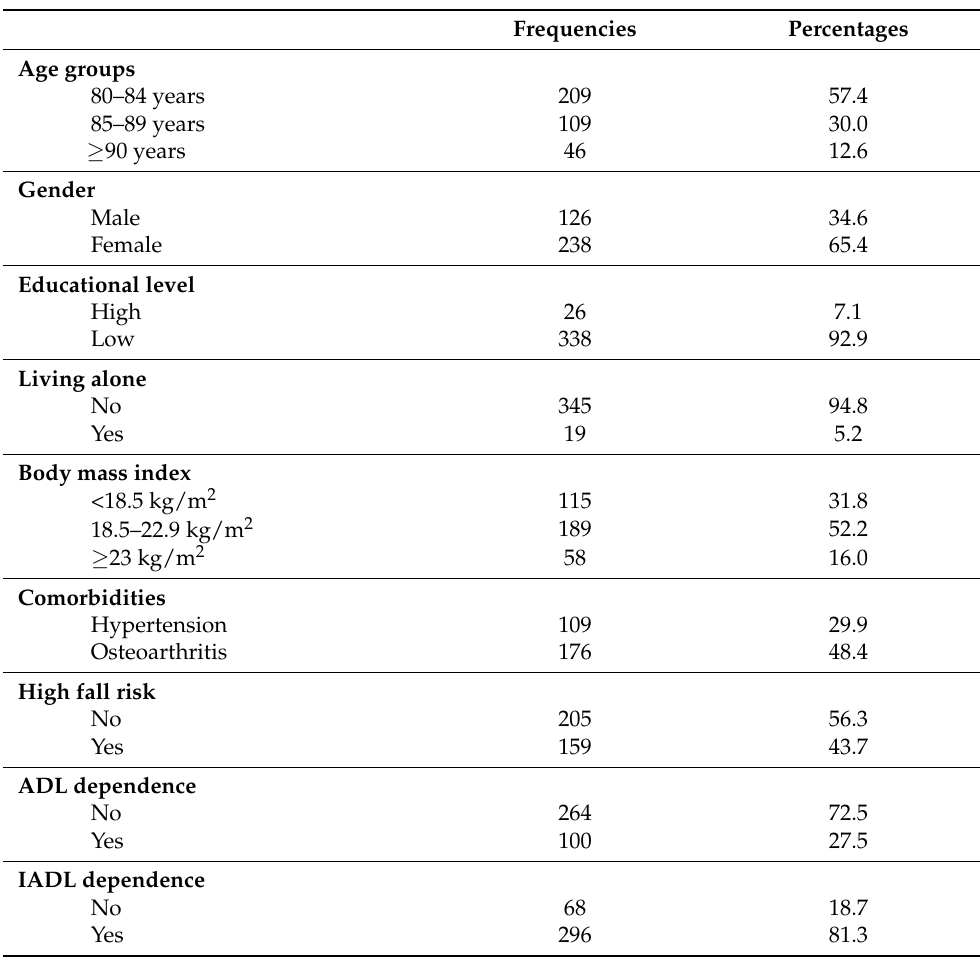
Table 1. Characteristics of the study participants (n =